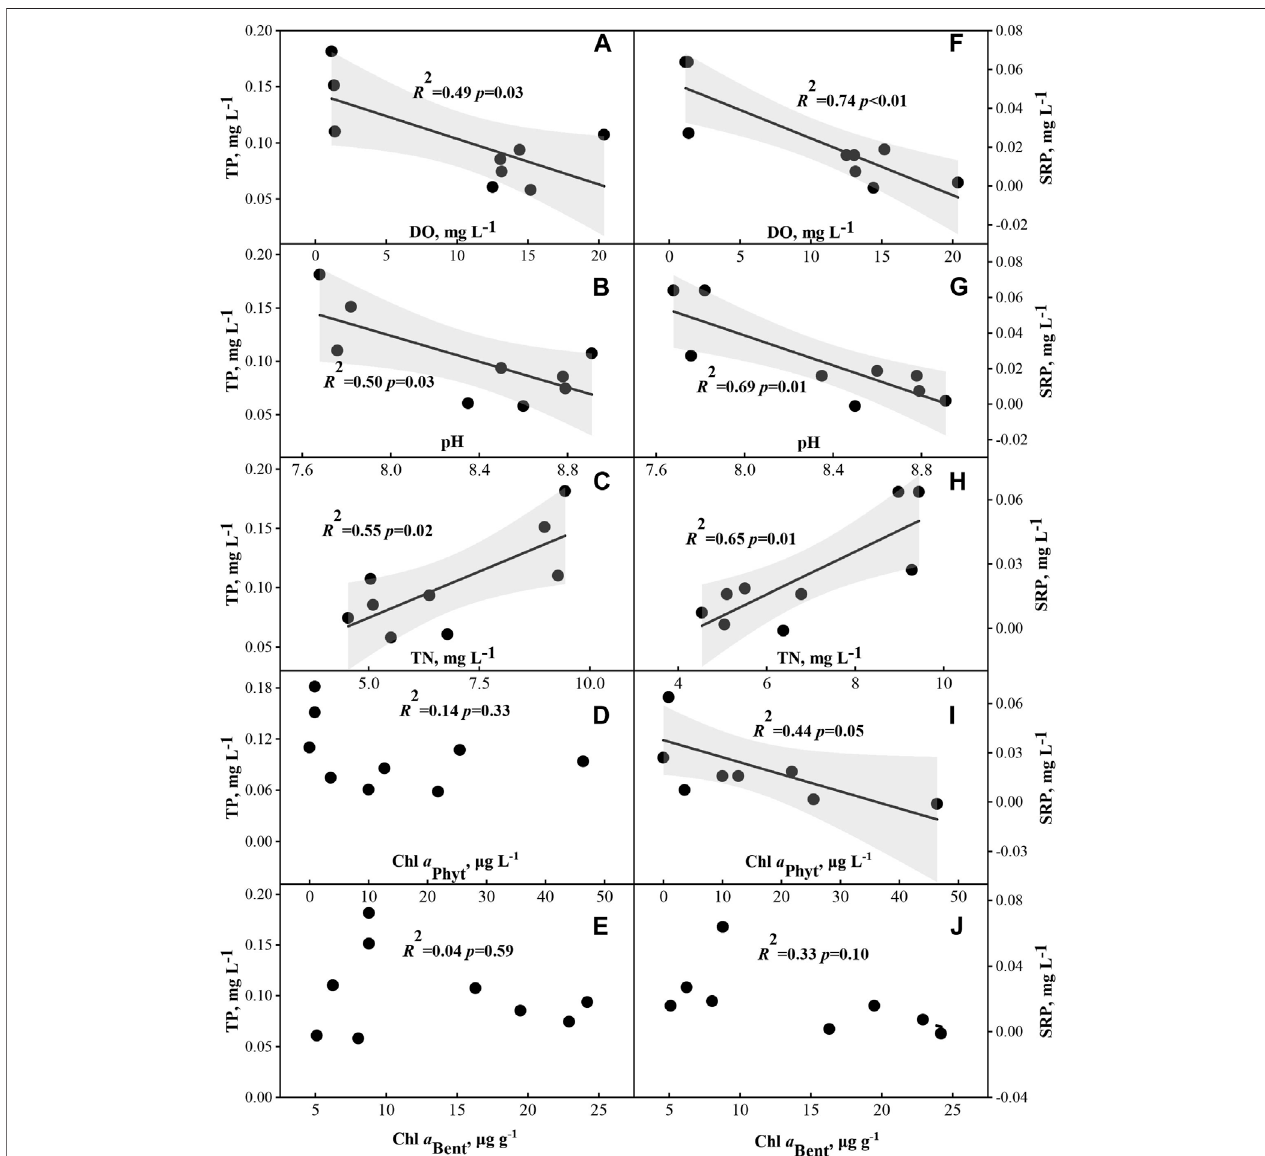
FIGURE 5 | Relationships between phosphorus variables (total phosphorus (TP) (A – E) ; soluble reactive phosphorus (SRP) (F – J) ) and dissolved oxygen (DO) ( n = 9), pH, total nitrogen (TN), phytoplankton chlorophyll a (Chl a Phyt ) and benthic algae chlorophyll a (Chl a Bent ).